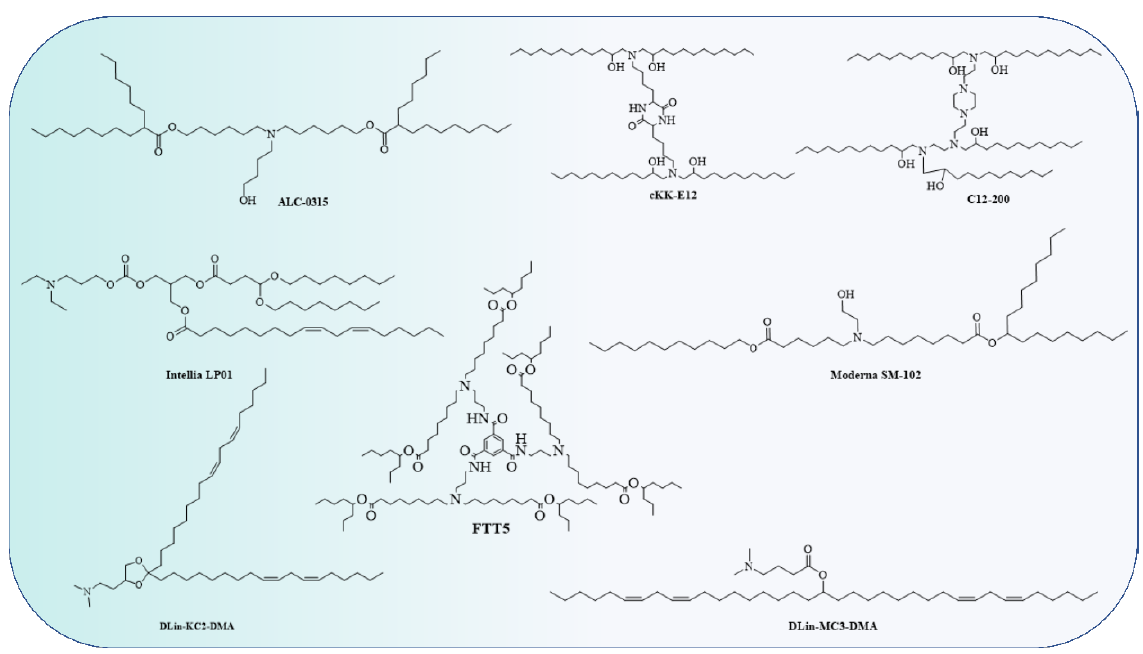
Figure 3. Though the lipids have different chemical structures and chain lengths, the presence of a tertiary amine at acidic pH takes a proton and turns it into a cation, i.e., a cationic lipid. This cationic lipid binds to the anionic part of RNA, forming a stable